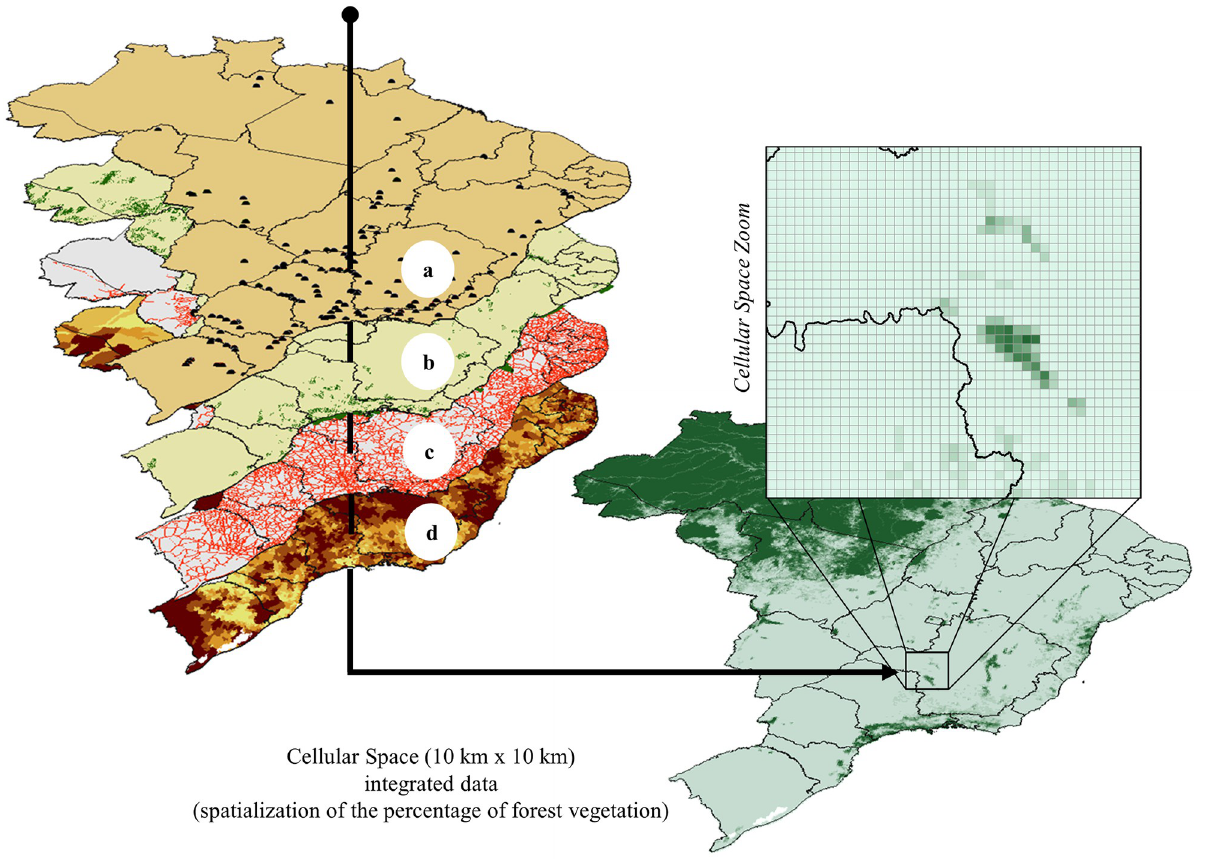
Fig 3. Representation of the factors integration into the cellular space. a) Hydroelectric plants, b) Protected areas, c) Federal and State highways, and d) Proportion of large agricultural establishments. The source of States boundaries is according to IBGE [31].